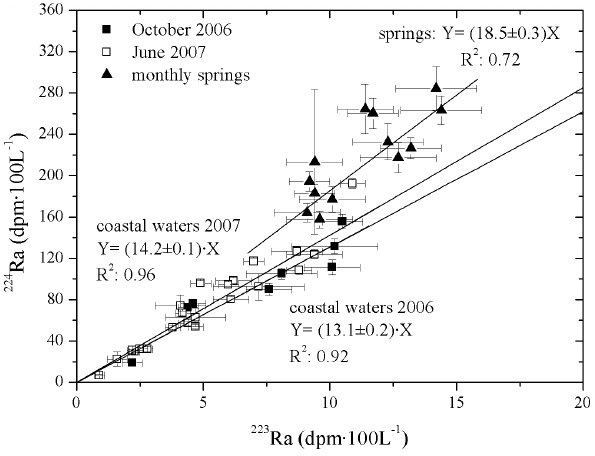
Fig. 9. 224 Ra activities plotted versus 223 Ra in surface waters from October 2006 and June 2007 and the monthly collected brackish springs. The best-fit lines for the three cases are also